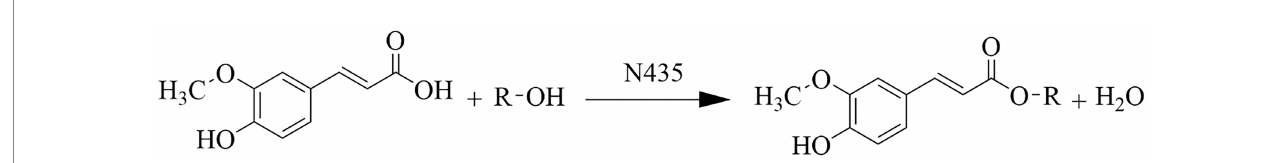
FIGURE 1 Ferulic acid reacts with fatty alcohol to form ferulic ester